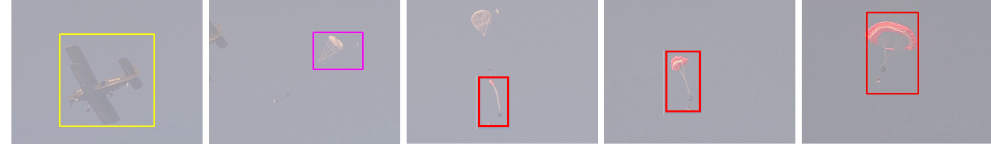
Figure 16. Multi-target